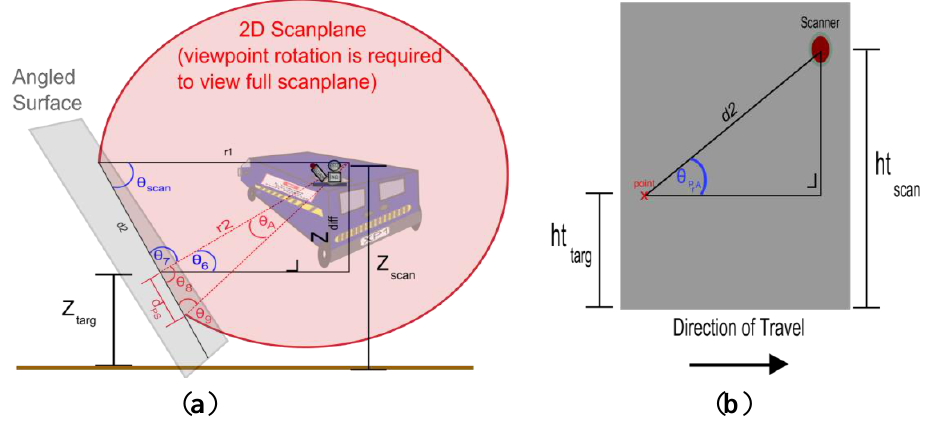
Figure 5. Calculating point spacing ( a ) MIMIC requires an adjusted height of scanner and height of target ( b ) adjusted for vertical rotation of